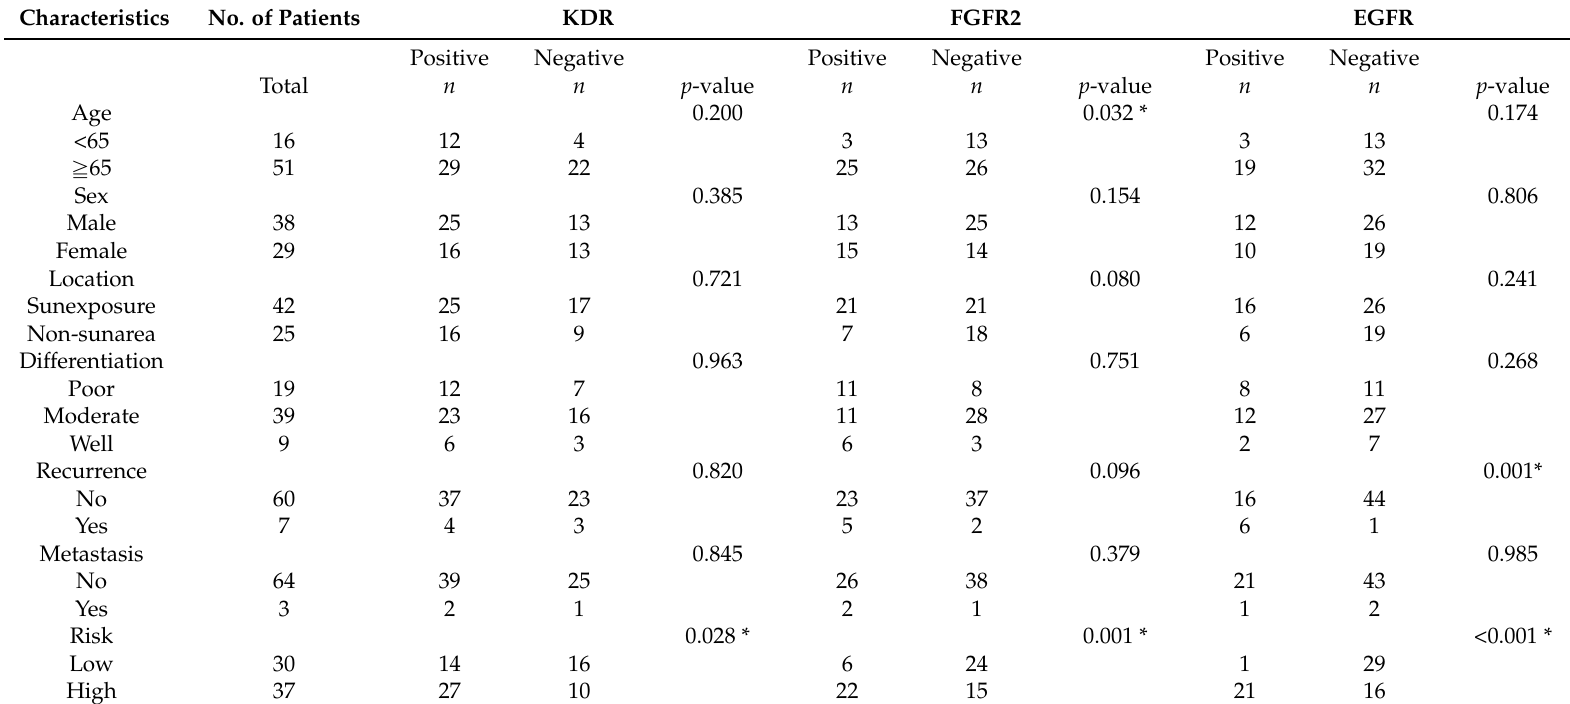
Table 4. Target genes (KDR, FGFR2, EGFR) expressions in cSCC specimens ( n =